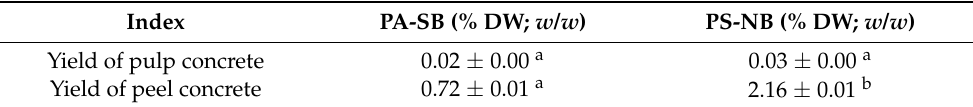
Table 7. Primary characteristics of fruit concretes obtained from two phenotypes of P. alkekengi (PA-SB and PA-NB).